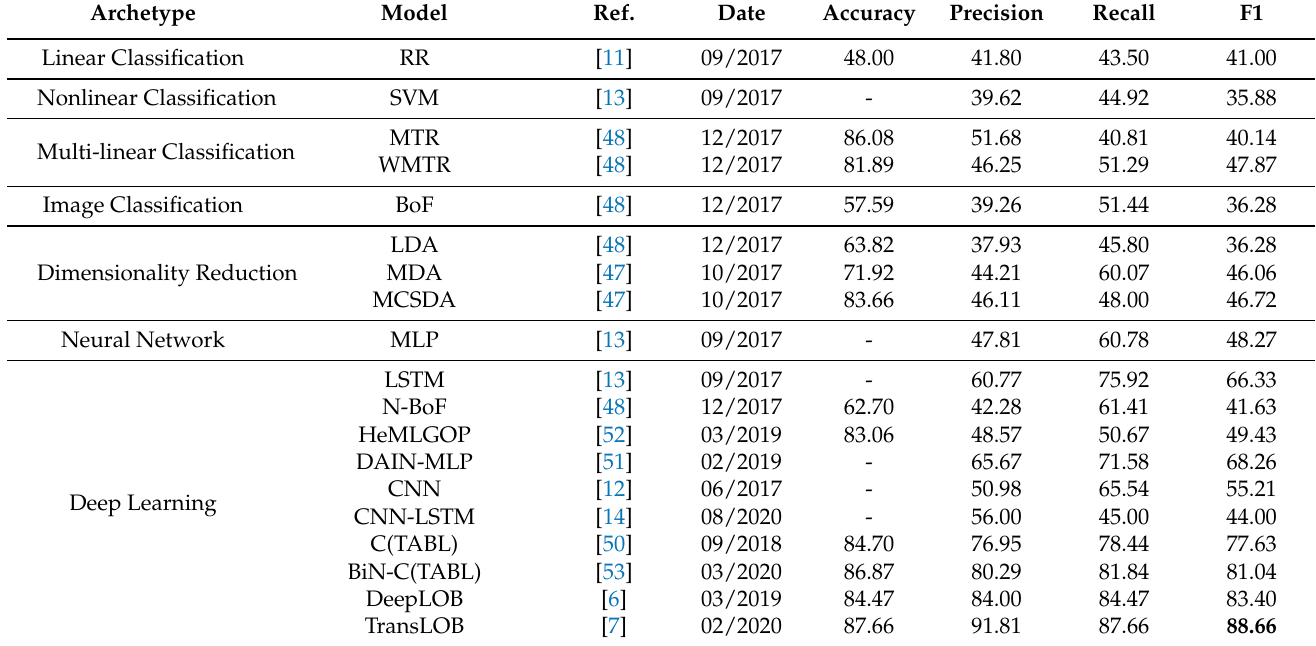
Table 3. State-of-the-art stock price prediction models performance on the benchmark LOB dataset.